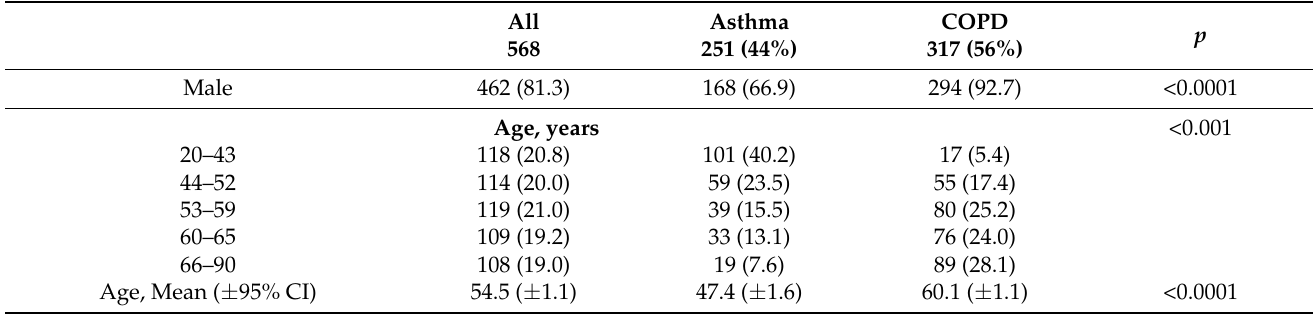
Table 2. Characteristics of whole asthma group (combined with ACO like-asthma) compared to the whole COPD group (combined with ACO-like COPD) [n